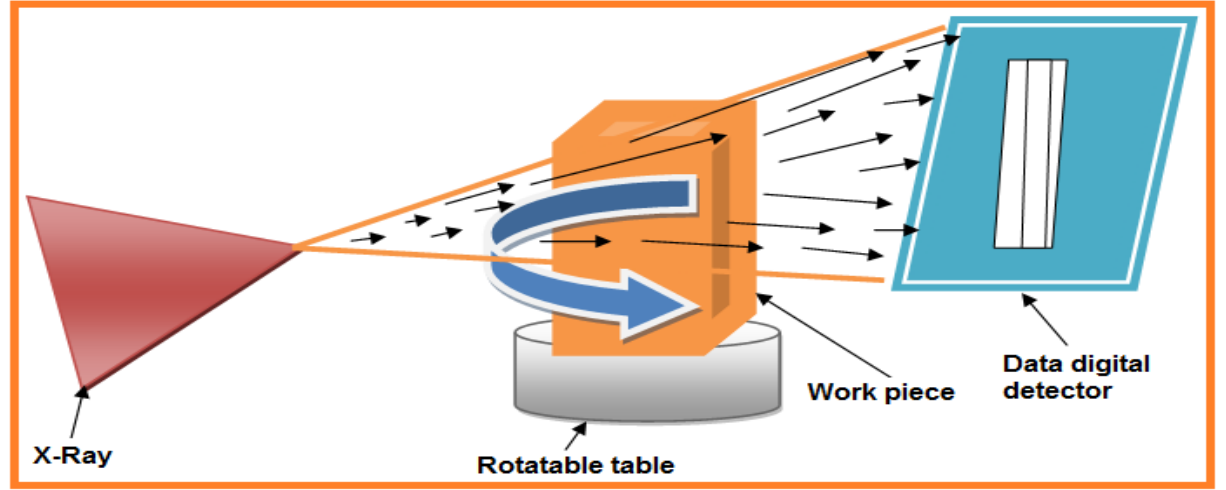
Figure 15. Line diagram of X-ray computed tomography (XCT) use in 3D printing technology.